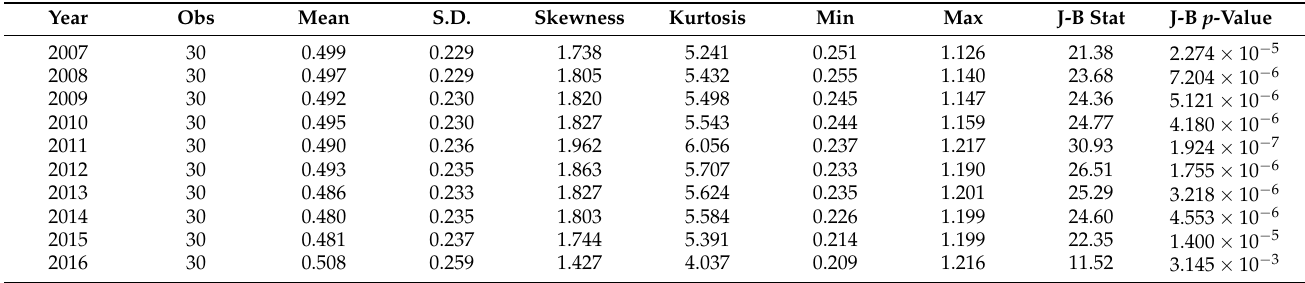
Table 2. The descriptive statistics of the annual carbon emission efficiency